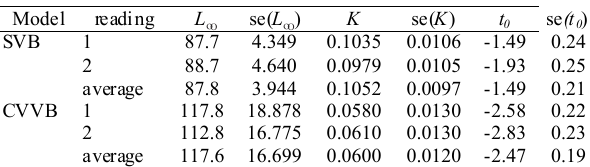
Table 2. Von Bertalanffy growth parameters estimate of the dog snapper Lutjanus jocu from Abrolhos Bank. t significantly different from zero, SVB = Constant variance for all ages, CVVB = Constant coefficient of variation for all ages and se = Standard error.